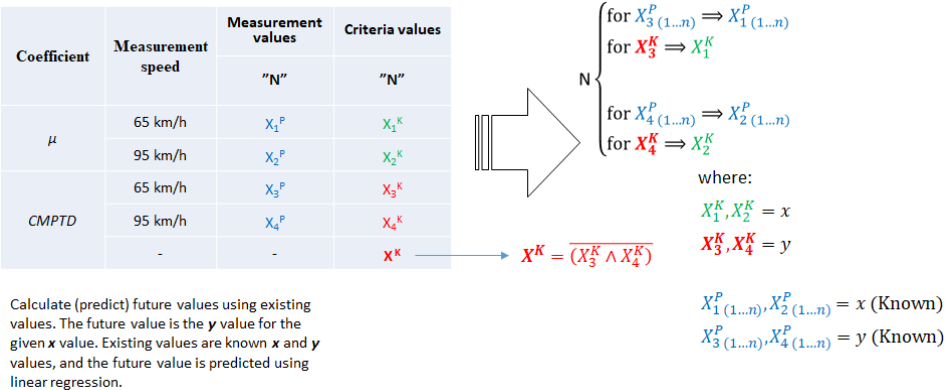
Figure 8. Determination of the search criteria—value estimation method.